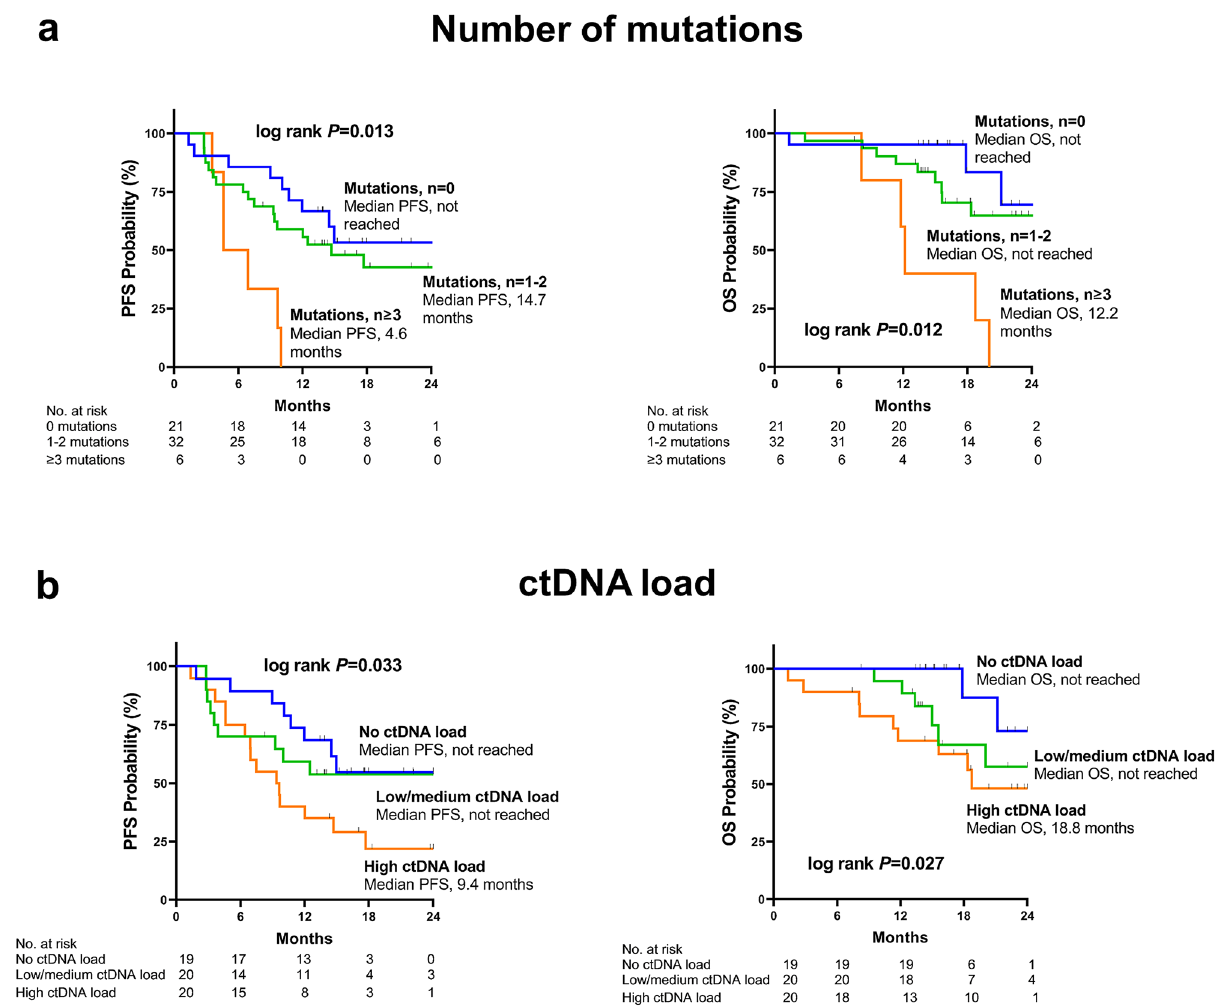
Figure 1. Kaplan–Meier estimates of survival according to ( a ) mutation number ( a ) and ( b ) ctDNA load. Number of likely-pathogenic or pathogenic mutations was categorized as 0 mutations, 1–2 mutations, and ≥ 3 mutations. Number of mutant ctDNA molecules per mL plasma was used to assess ctDNA load, which was categorized into tertiles. No (zero) ctDNA load was defined by the first tertile, a low/medium ctDNA load was defined by the second tertile, and a high ctDNA load was defined by the third tertile of mutant ctDNA molecule concentration. P-values were obtained by Log-Rank-Mantel-Cox-tests. PFS, progression-free survival; OS, overall